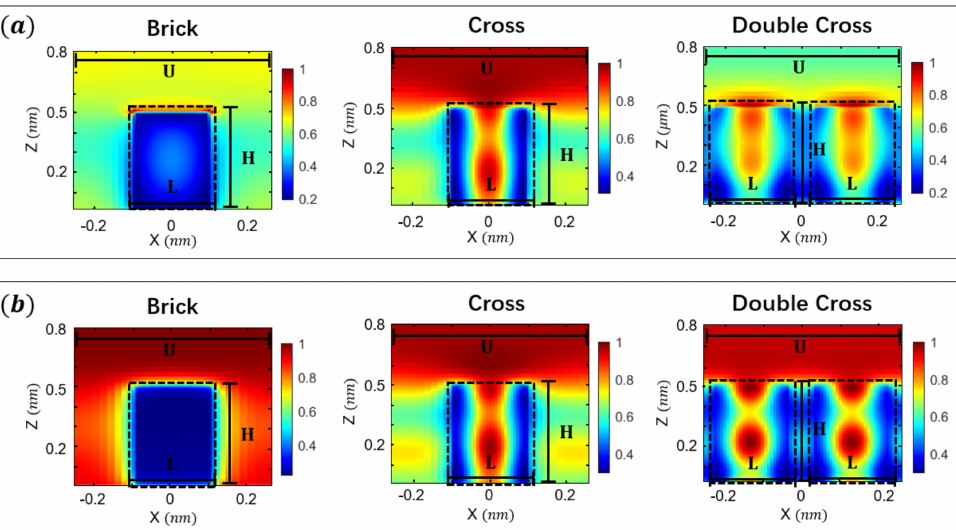
Figure 4. Energy distribution of the electric field on the cross section of the three unitcells. The colorbars represent the intensity of the electric field at different positions, and the intensity is normalized to the maximum intensity in each graph. ( a ) 15 ◦ incident light; ( b ) 0 ◦ incident light. The dimensions (L, H, U) of the structures here are L = 189 nm, H = 500 nm, U = 520